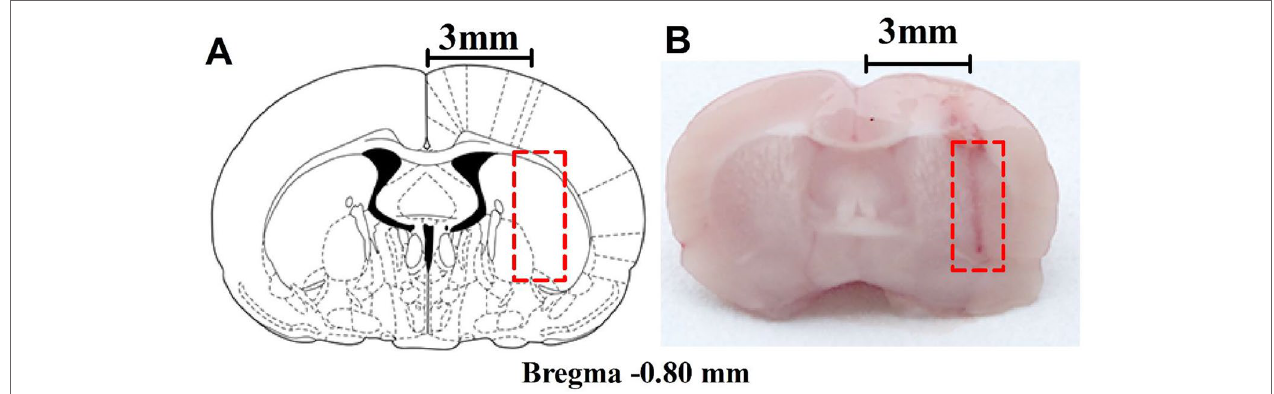
FIgURE 1 | Anatomical placements of microdialysis probes. (a) The dialysis membrane was designed to be in the lateral part of the striatum (based on Paxinos and Watson, 2005). (B) Histological location of microdialysis examined in the brain. The numbers refer to the distance from bregma.